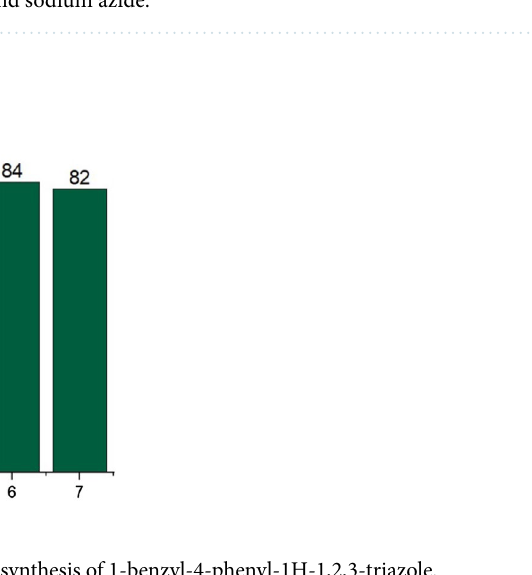
Table 5. Comparison of catalytic activity of the present catalyst with some other reported methods in the click reaction of phenylacetylene, benzyl bromide, and sodium azide.